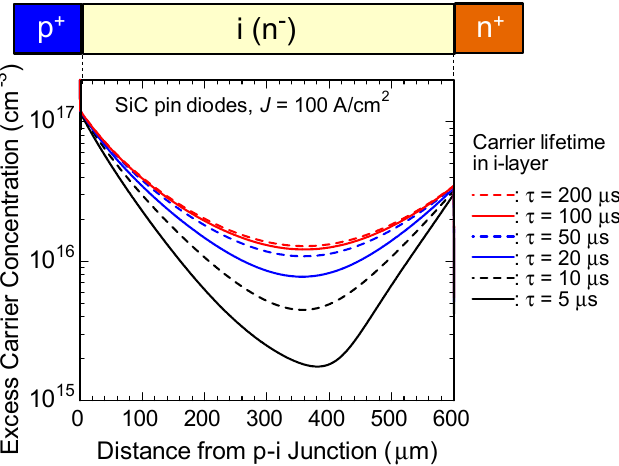
Figure 6. Profiles of excess carrier concentration inside the i-layer at a current density of 100 A/cm 2 for a SiC pin diode. The i-layer thickness is 600 µm and the carrier lifetime was varied from 5 µs to 200 µs.